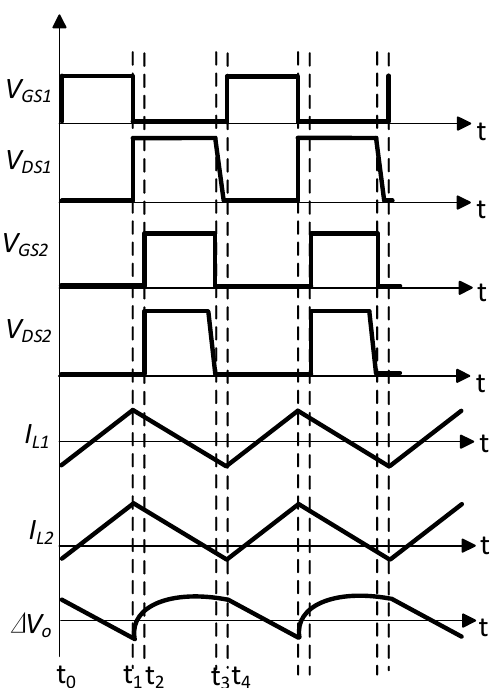
Figure 9. TCM SEPIC converter with zero voltage switching (ZVS) waveform.